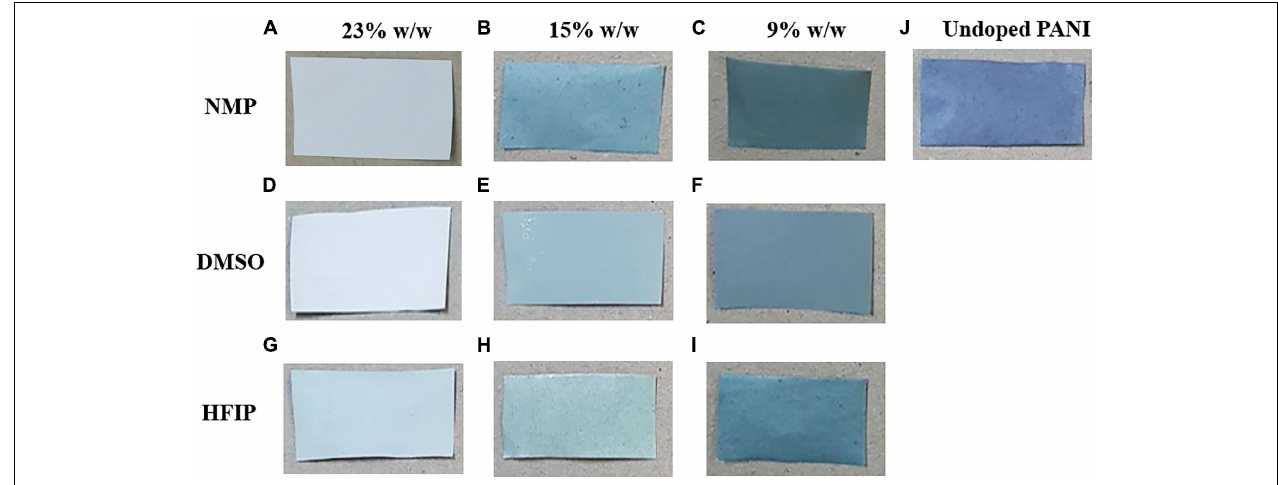
FIGURE 4 | Digital photograph showing the color of PPC nanofibers changing from white to light green and dark green by decreasing the amount of PES in the nanofibers. Nanofibers prepared with NMP (A–C) , DMSO (D–F) , and HFIP (G–I) . PES/Undoped-PANI nanofibers (J) .